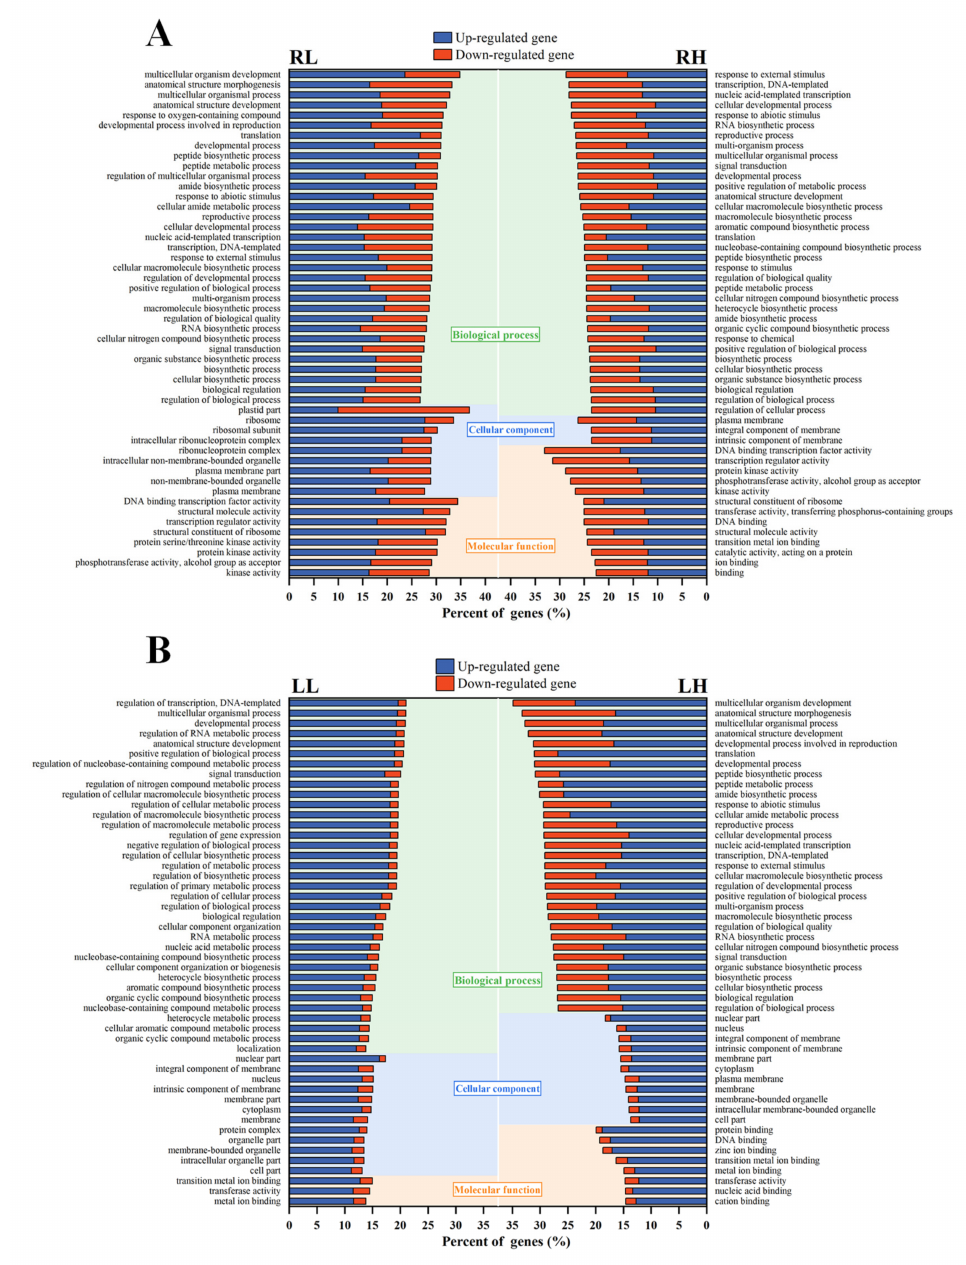
Figure 4. Significantly enriched Gene Ontology (GO) terms (top 50) for differentially expressed genes (DEGs) in roots ( A ) and leaves ( B ) of Myriophyllum aquaticum. LL and RL, leaf and root from low phosphorus concentration treatment; LH and RH, leaf and root from high phosphorus concentration